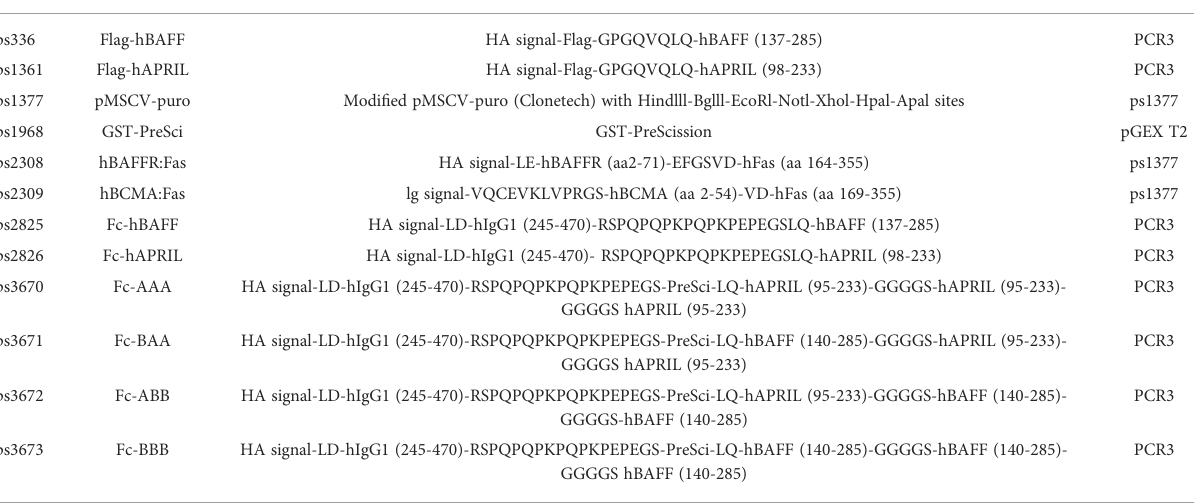
Table 1. Anti-mAPRIL antibody clone Heaty-1